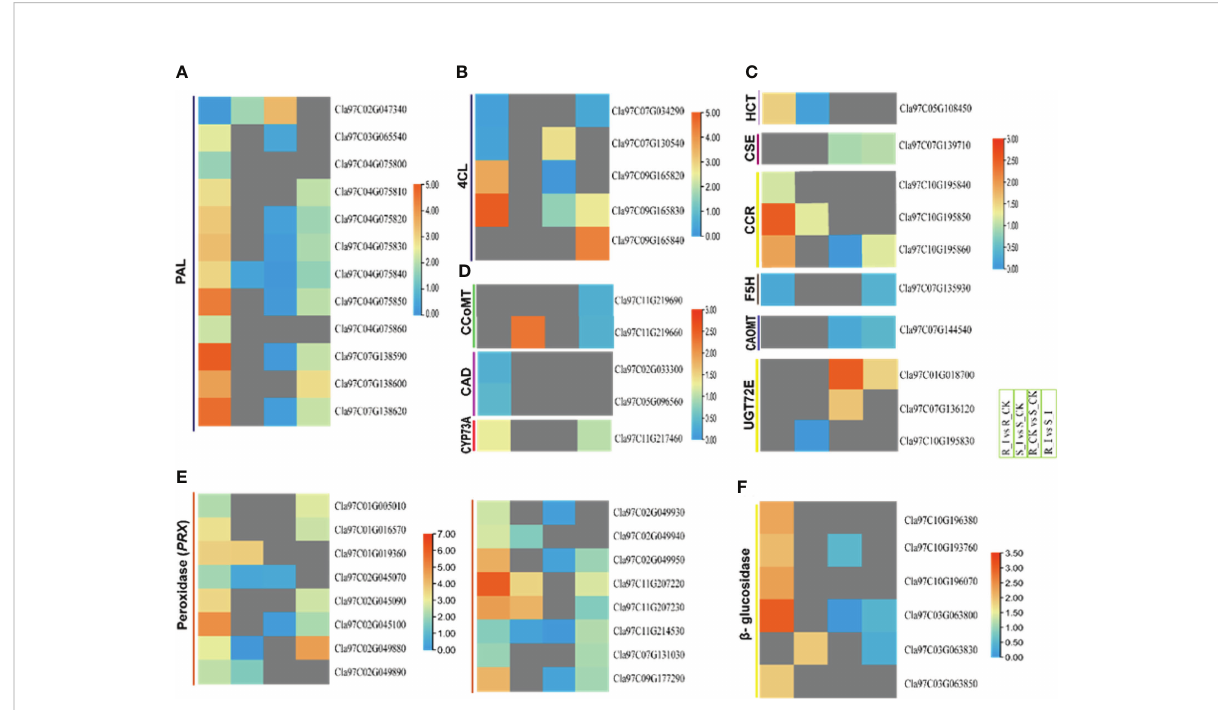
FIGURE 8 Heatmap of the genes linked to the general phenylpropanoid pathway, peroxidase and beta-glucosidase were identi fi ed with differential expression in PM invasion of resistant and susceptible watermelon lines, over early stages of invasion in leaves. Selected DEGs from the PAL (A) , 4CL (B) , HCT, CSE, CCR, F5H, CAOMT (C) , CCoAOMT, CAD, CYP73A (D) , peroxidase ( PRX ) (E) and b -glucosidase (F) gene families from different comparative combination groups R_I vs. R_CK, S_I vs. S_CK, R_CK vs. S_I vs. S_I are presented in form of a heatmap. Log FC values corresponding to each gene in a group are used to generate a heatmap. The red and blue colours specify up-and down-regulated